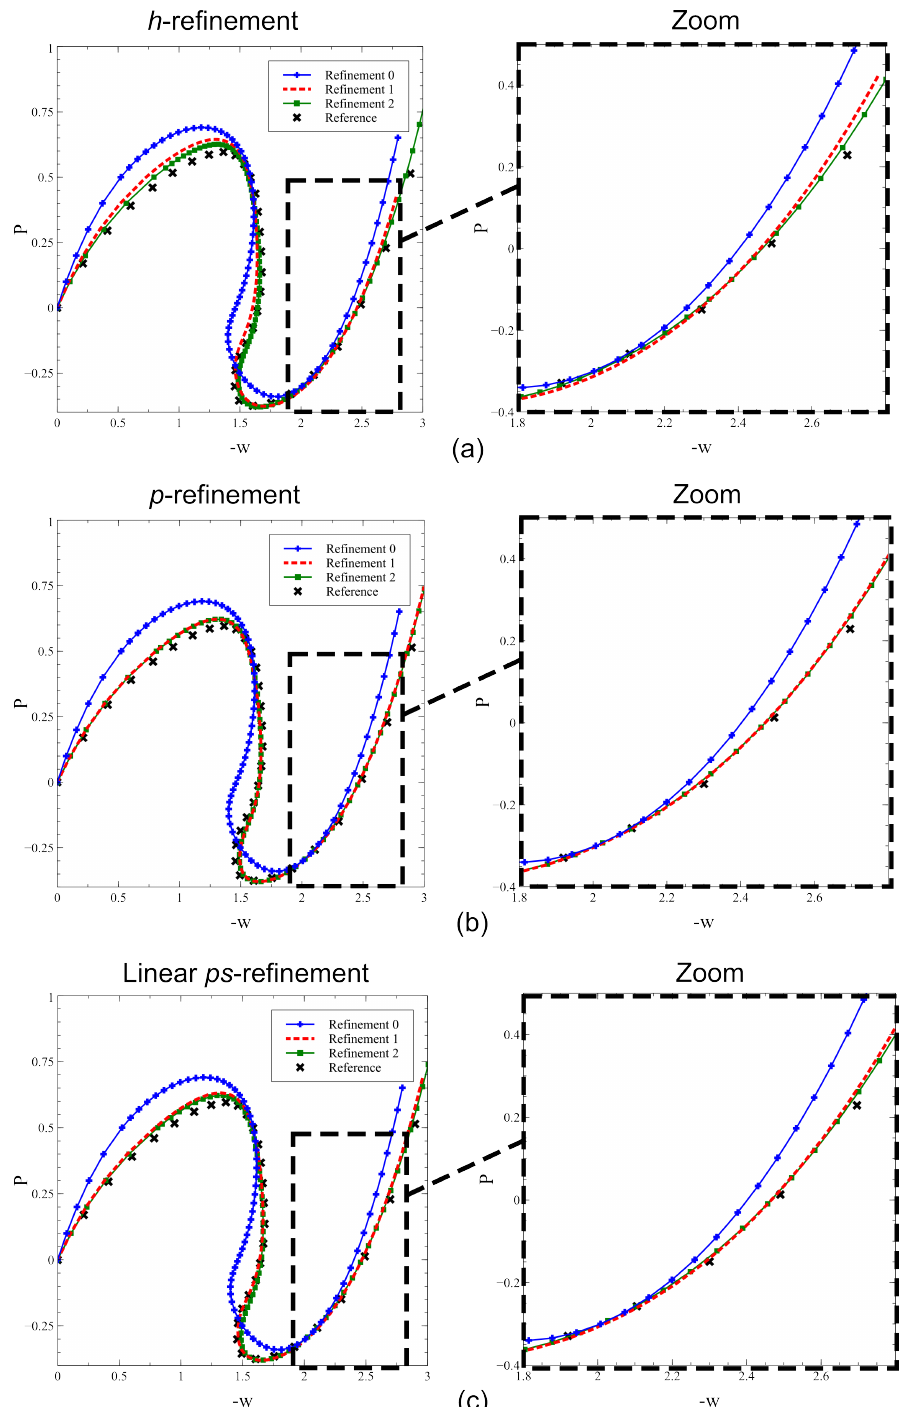
Figure 24. Cylindrical panel: load − deflection curves for different levels of ( a ) h − , ( b ) p − and ( c ) ps −